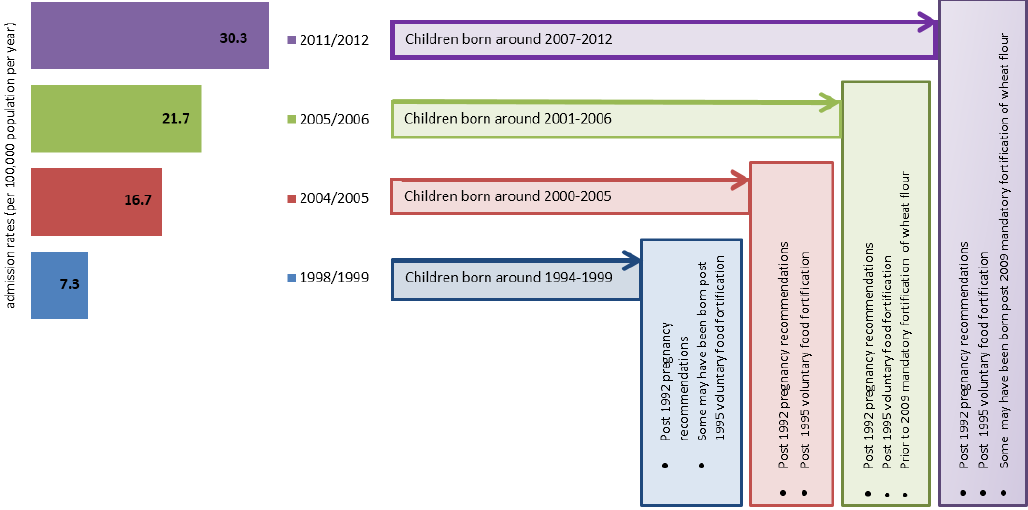
Figure 1. Food-related anaphylaxis hospital admissions rates (per 100,000 population per year) of children aged 0–4 years in Australia between 1998/99 and 2011/12, and the timing of Australian folic acid public health measures. Source: Adapted from Mullins, R.J. et al. [1].